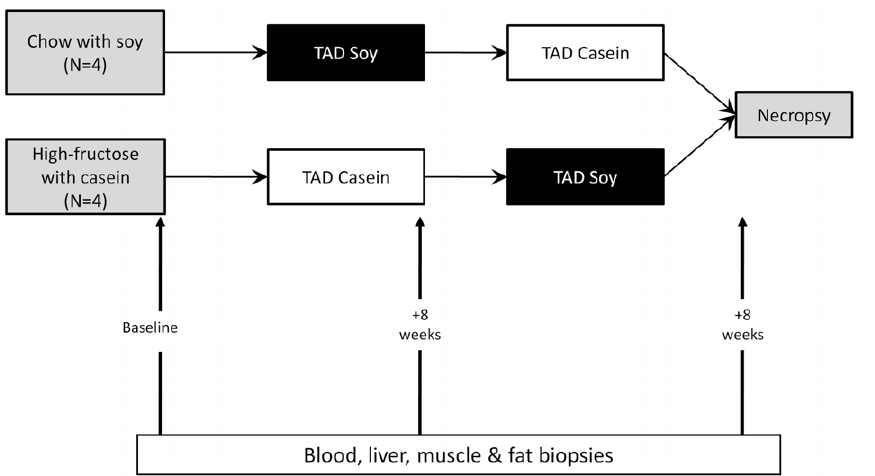
Figure 1. Study Design. Four cynomolgus monkeys were included in each diet arm. Measurements for clinical variables were performed after four weeks on each diet. DNA was isolated from blood, fat, liver, and muscle at the end of each diet period.